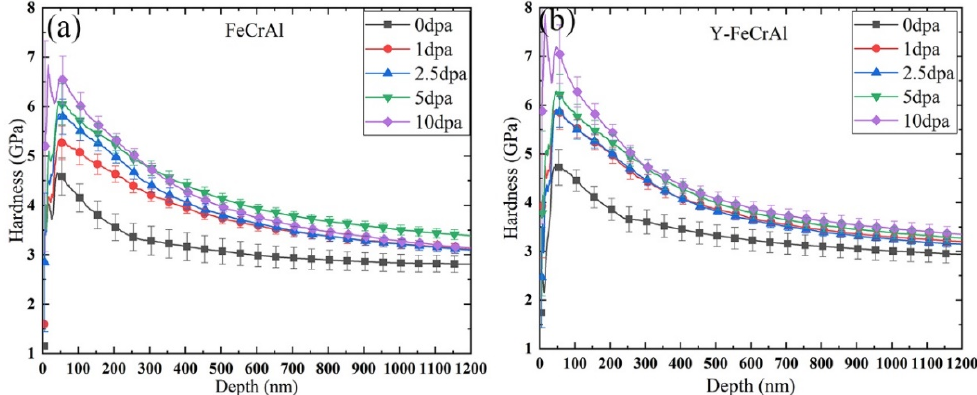
Figure 9. Average hardness as a function of indentation depth of ( a ) FeCrAl, ( b ) Y − FeCrAl alloys at different doses.